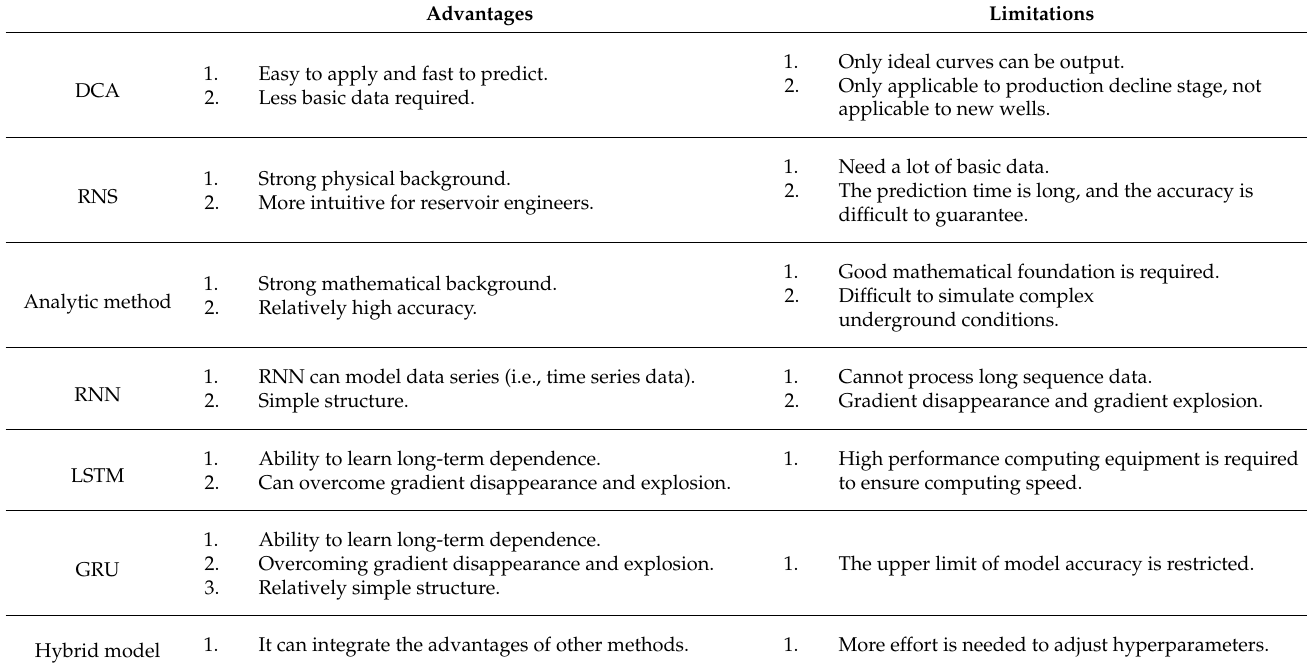
Table 1. Advantages and limitations of the current